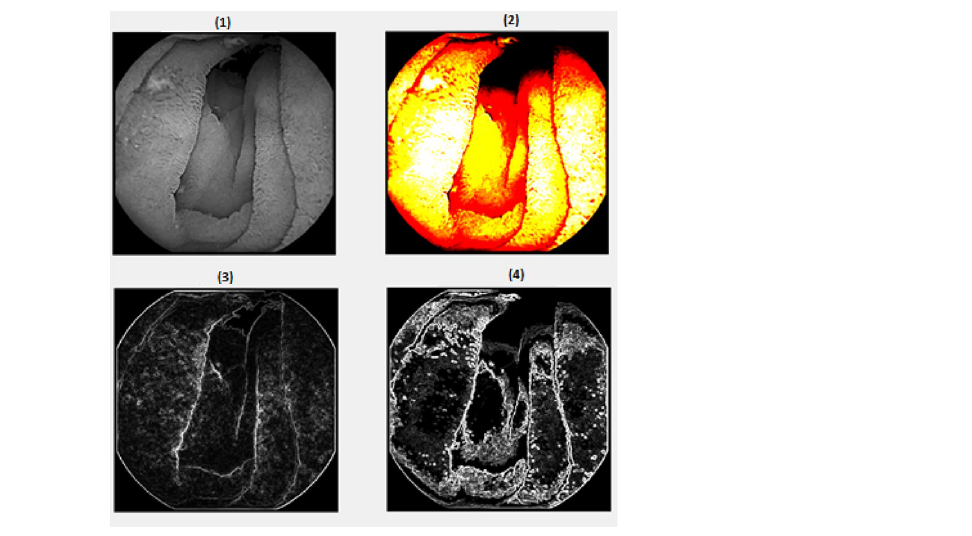
Figure 6. Modification to the Sobel filter. (1) Black and white Image, (2) contrast adjustments, (3) simple Sobel filter, (4) final